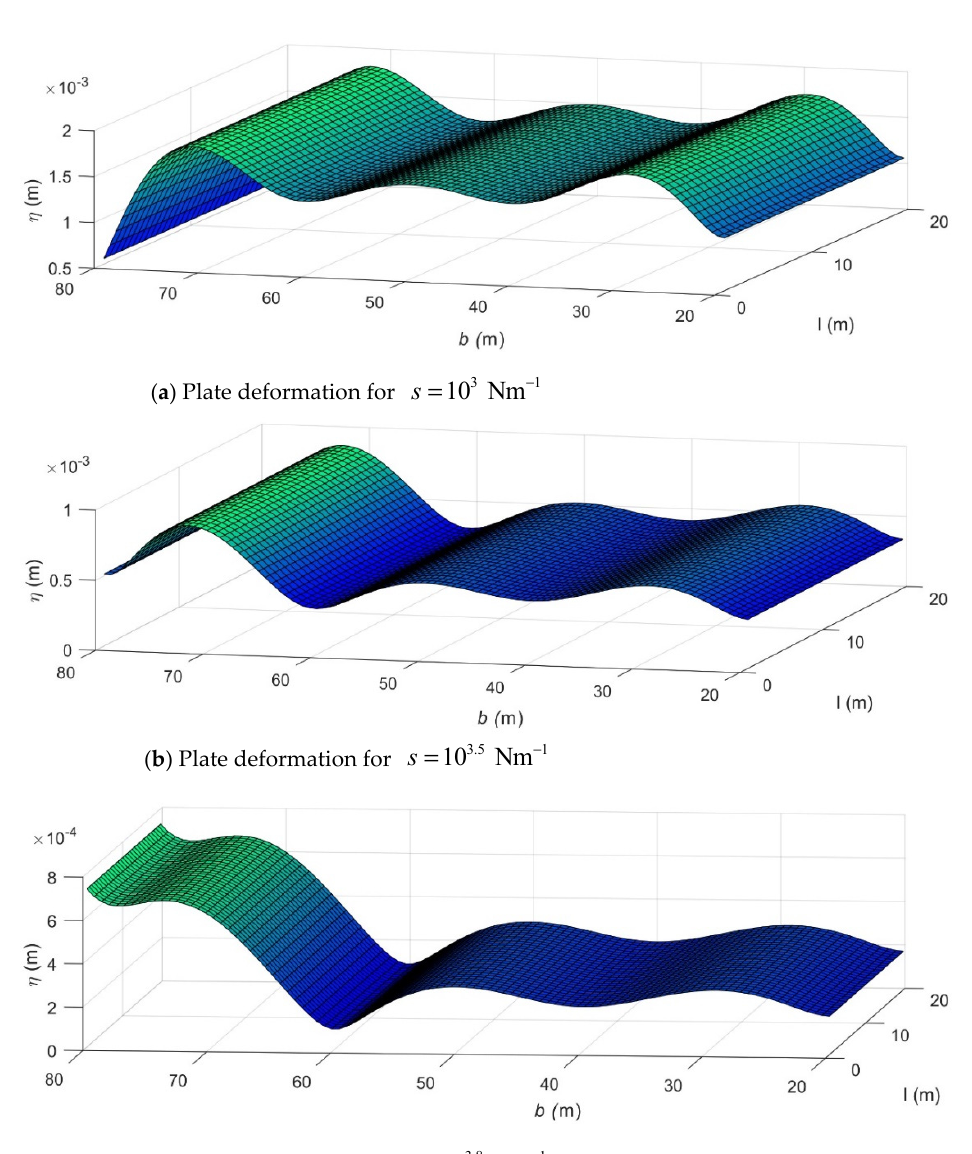
Figure 8. Effect of mooring stiffness on the deformation of the moored floating flexible plate.